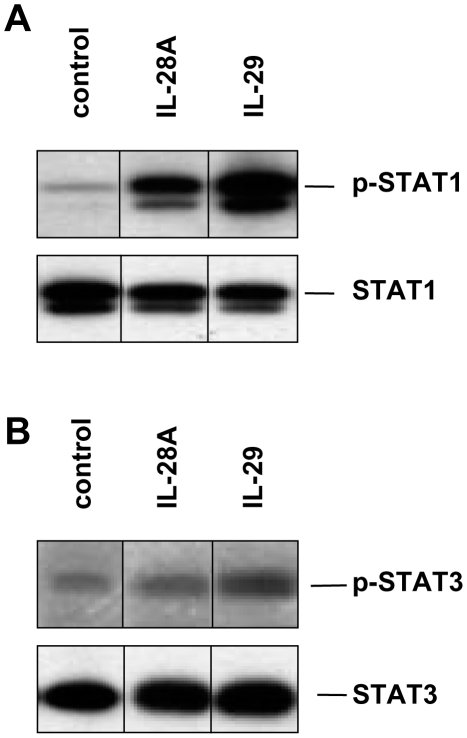
IL-28A and IL-29 strongly activate STAT1 but not STAT3 in naïve Huh-7 cells.Activation and expression of phospho-STATs and protein loading of the respective STAT proteins were assessed by immunoblotting. (A) Phospho-STAT1 activation after 15 min of stimulation with IL-28A and IL-29 (100 ng/ml). (B) STAT3 is phosphorylated only to a low extent by stimulation with IL-29 but not with IL-28A. One representative experiment (n = 3) is shown.